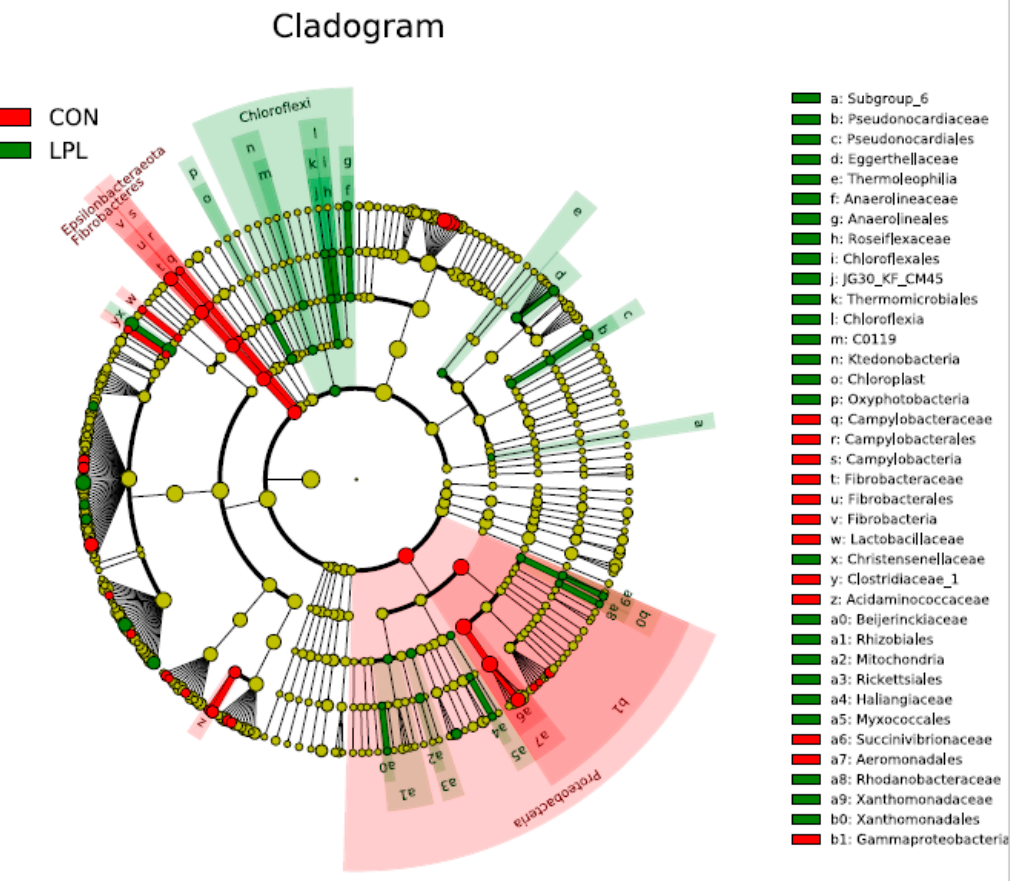
Figure 1. LEfSe cladogram of the composition of bacterial community in the rumen fattening lambs fed a diet supplemented without (CON) or with (LPL) 0.05% lysophospholipid. Differences are represented in the color of the group, where taxa are most abundant. Red: taxa abundant in CON; Green: taxa abundant in LPL.